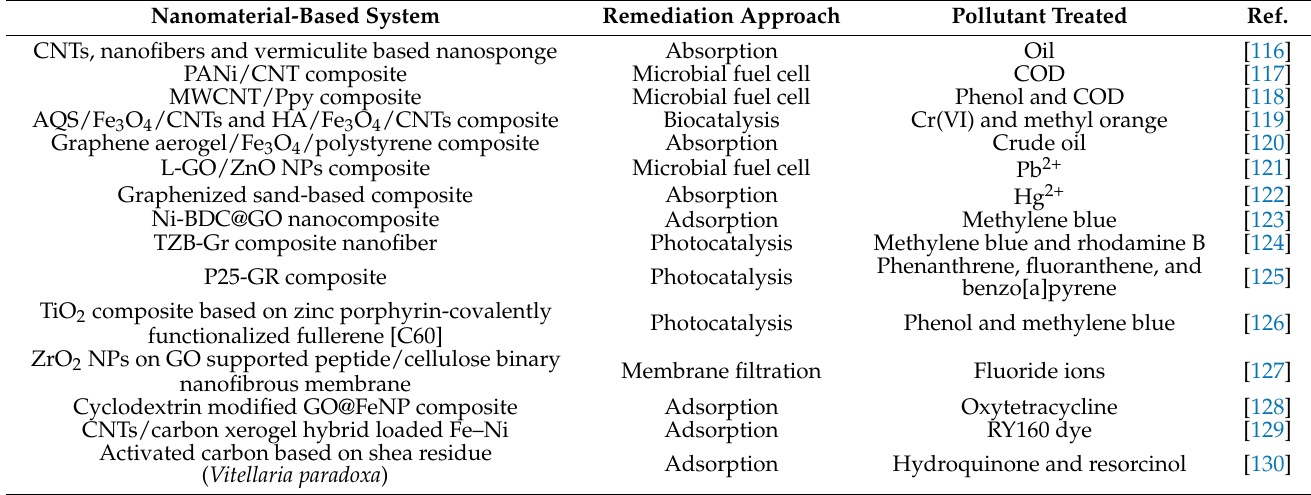
Table 4. Carbon-nanomaterial based systems for remediation and bioremediation